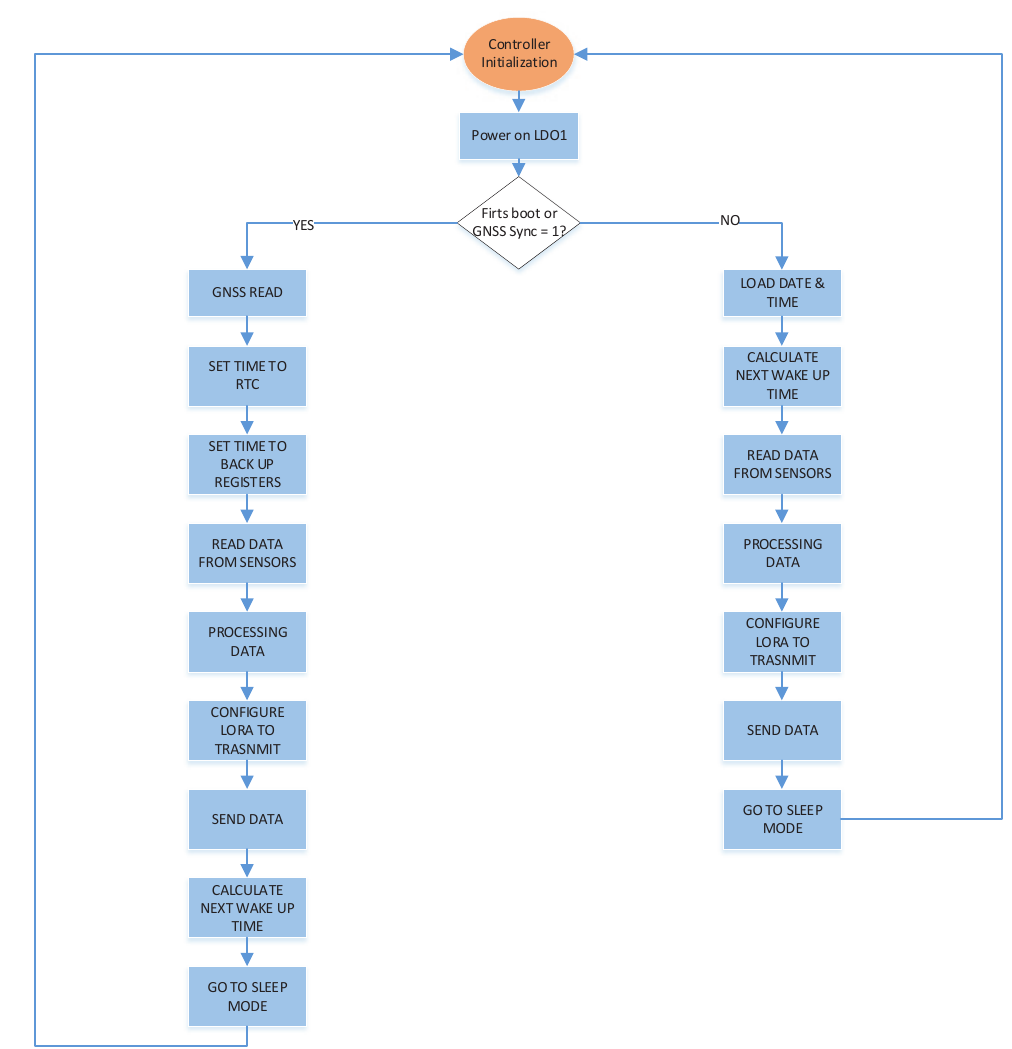
Figure 6. Flow chart of the Sensor node